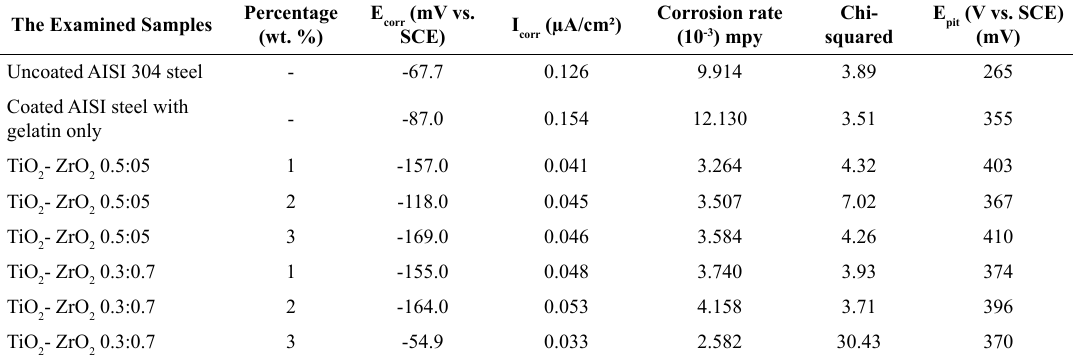
Table 2. Corrosion rates and electrochemical constant values for the uncoated AISI -304 steel sample and the AISI 304 steel coated with hybrid TiO -ZrO nanoparticles dispersed in gelatin 2 2